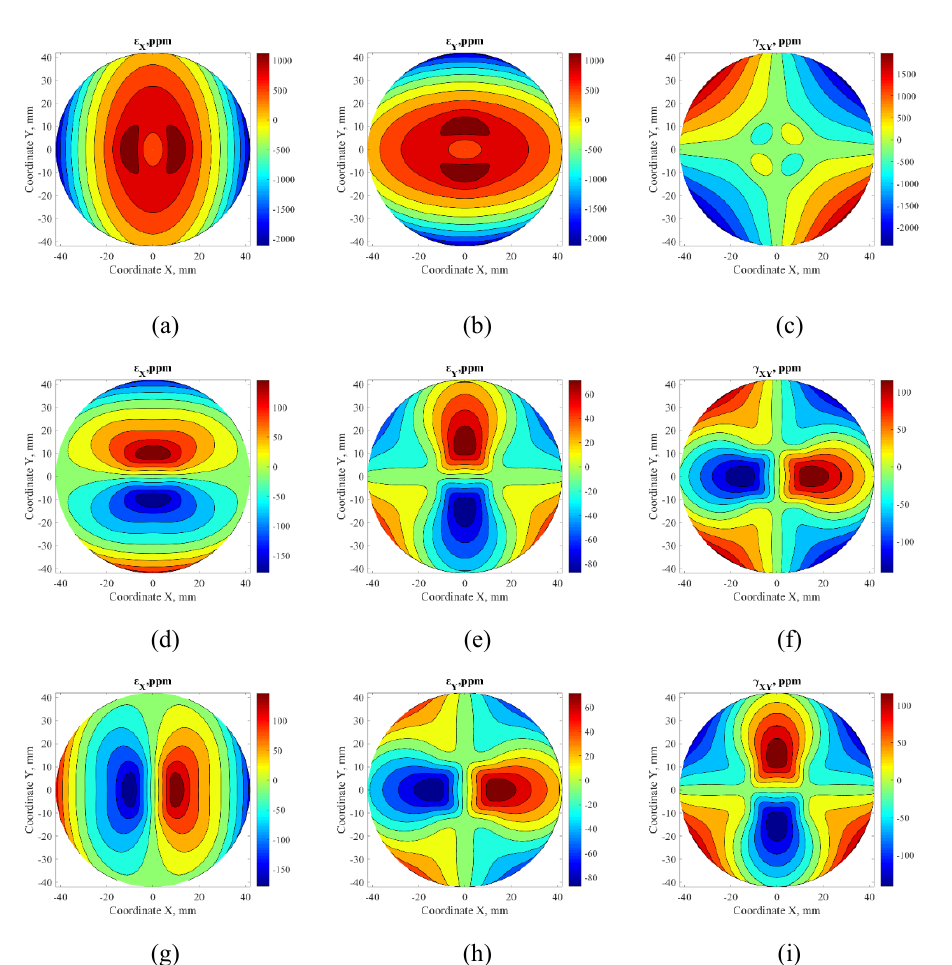
Fig. 4. Strain state components when sensor is loaded with F (a, b, c), Mx (d, e, f), My (g, h,